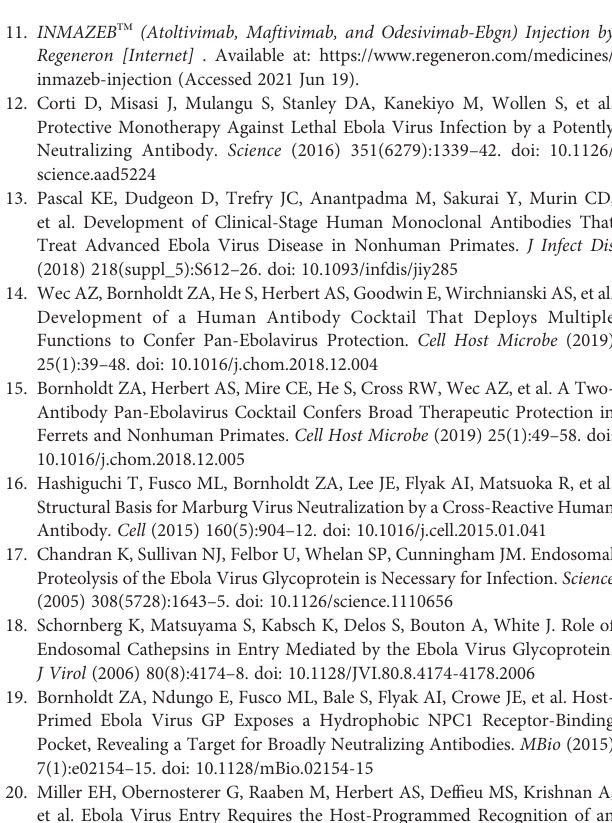
Supplementary Figure S1 | Biochemical characterization of antibodies and puri fi ed proteins. Puri fi ed antibodies (A) 548, 548~IGF2_HCN and 548~NPC2_LCN and (B) MR72, MR72~IGF2_HCN and MR72~NPC2_LCN were resolved by SDS-PAGE under reducing conditions. HCN, IGF2 or NPC2 fused to the N-terminus of the IgG heavy chain. LCN, IGF2 or NPC2 fused to the N-terminus of the IgG light chain. IgG heavy (H) and light (L) chains were visualized by Coomassie Brilliant Blue staining. Puri fi ed (C) CI-MPR Domains 1-3, (D) CI-MPR Domains 11-13, (E) NPC2 proteins were resolved by SDS-PAGE under nonreducing (NR) and reducing (R) conditions and visualized by Coomassie Brilliant Blue staining. Supplementary Figure S2 | mAb-548 – containing bsAbs cause endo/lysosomal free cholesterol accumulationbut donot affect cellviability. (A) Filipinstaining of U2OS cells treated with the indicated antibodies (1 nM or 350 nM) or U18666A (positive control (54); 10 µM) for 14 h. (B) U2OS cell viability was determined by CellTiter-Glo assay following incubation with the indicated antibodies (1 nM or 350 nM) for 14 h. Means ± SD are shown for 4 replicates from 2 independent experiments. Supplementary Figure S3 | Breadth of neutralization by Trojan horse bsAbs. Neutralization curves for (A) the mab-548 Trojan horse bsAb panel and (B) the MR72 Trojan horse bsAb panel against rVSVs bearing fi lovirus glycoproteins. IC 50 values were calculated from curves for Figure 8A . Means ± SD are shown for 4 – 6 replicates from 2 – 3 independent experiments. EBOV, Ebola virus; TAFV, Tai Forest virus; BDBV, Bundibugyo virus; BOMV, Bombali virus; SUDV, Sudan virus; RESTV, Reston virus; LLOV, Lloviu virus; MLAV, Mengla virus; MARV, Marburg virus. Supplementary Figure S4 | NPC2- and IGF2-tagged bsAbs neutralize VSV- MARV in THP-1 cells. Neutralization activity of (A-B) mAb-548 – containing bsAbs and (C-D) MR72-containing bsAbs against rVSV-MARV GP in differentiated THP-1 cells. Infection was measured by automated counting of eGFP+ cells and normalized to infection in absence of antibody. Means ± SD are shown for 4 replicates from 2 independent